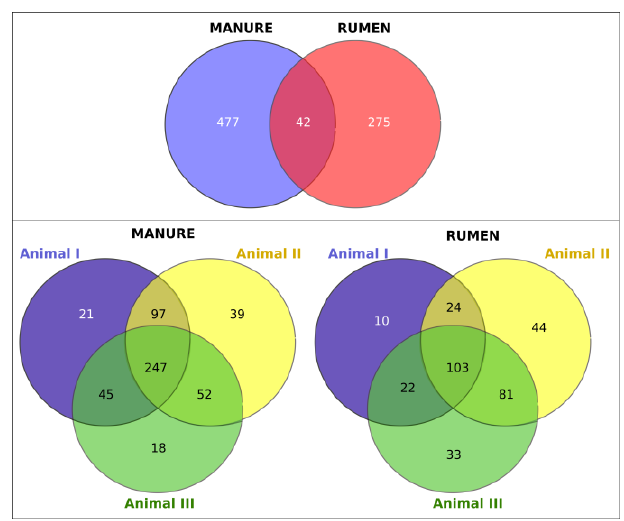
Figure 2. Venn diagrams of the bacterial communities showing the number of shared and unique operational taxonomic units (OTUs) in the rumen and manure samples.